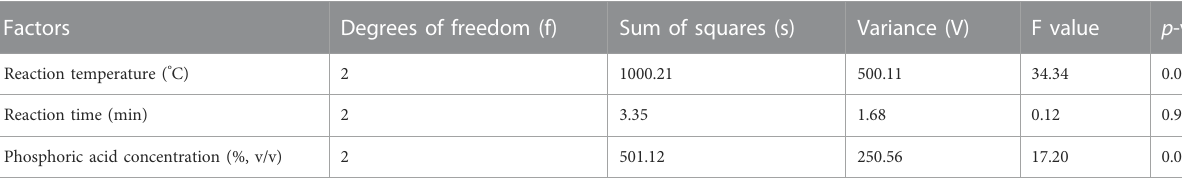
TABLE 3 Variance analysis results for all parameters. Factors Degrees of freedom (f) Sum of squares (s)